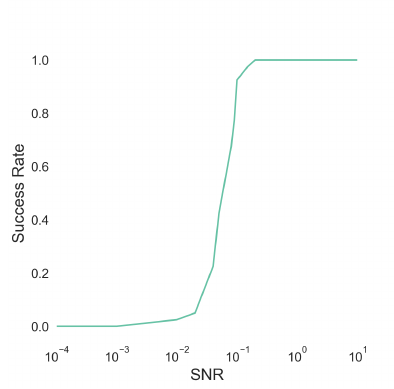
Figure 9: Success Rate of the second step of the attack with 256 traces.